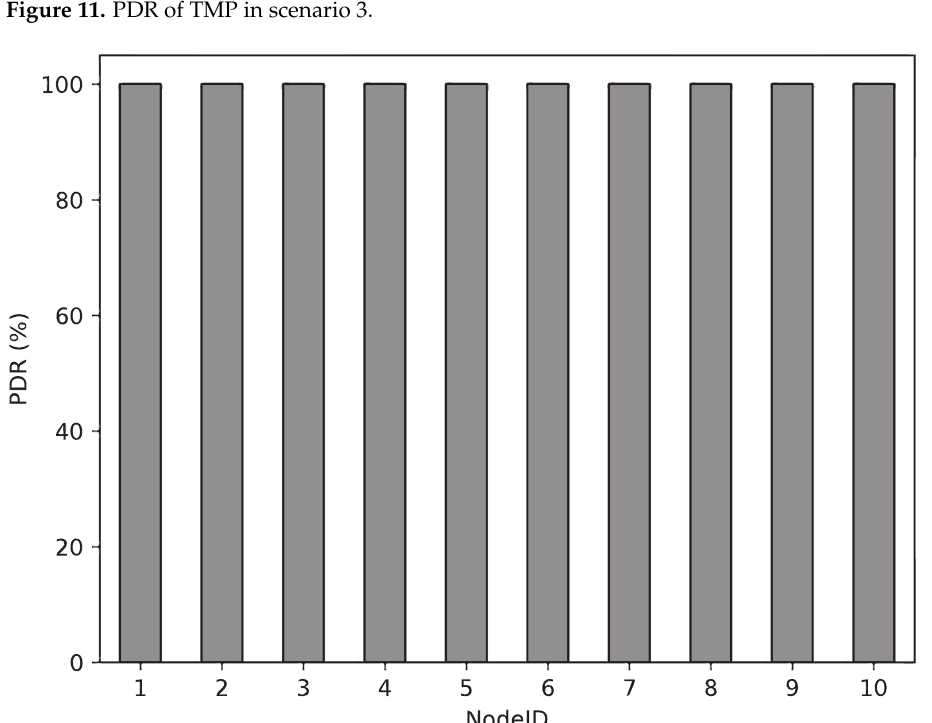
Figure 12. PDR of proposed method in scenario